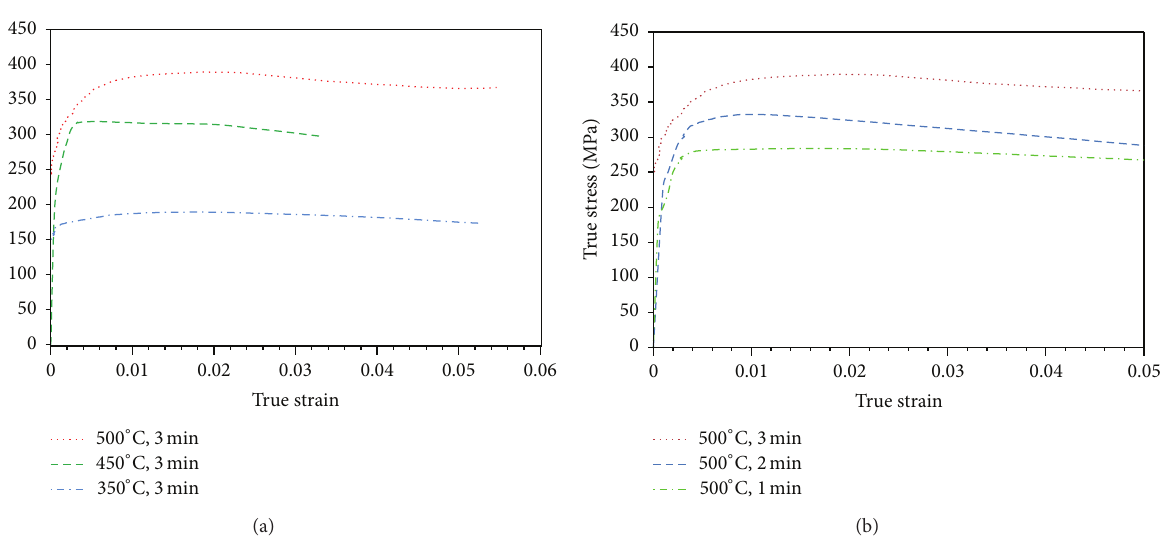
Figure 10: True stress strain response in simple compression of consolidated samples at different sintering temperatures for a constant sintering time of 3 minutes in (a) and for different sintering times for a constant sintering temperature of 500 ∘ C. The heating rate used was 800 ∘